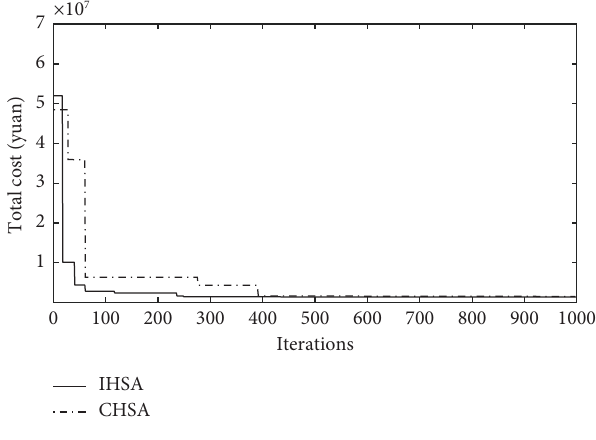
Figure 13: Iterative process